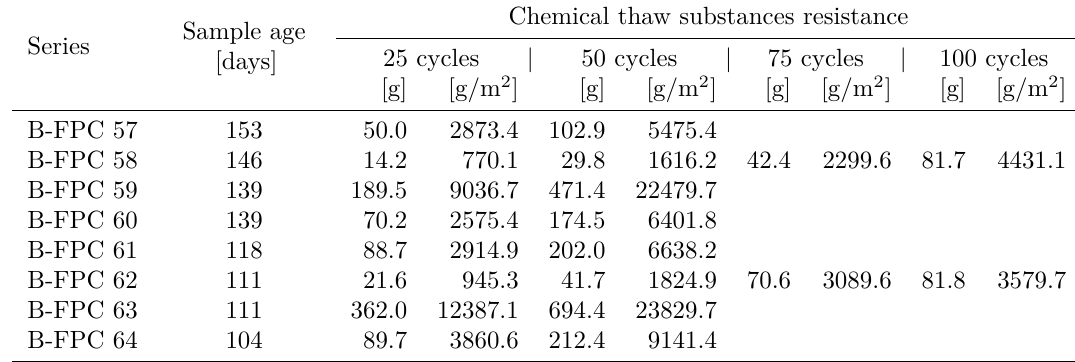
Table 3. Results of the chemical thaw substances resistance tests [19].